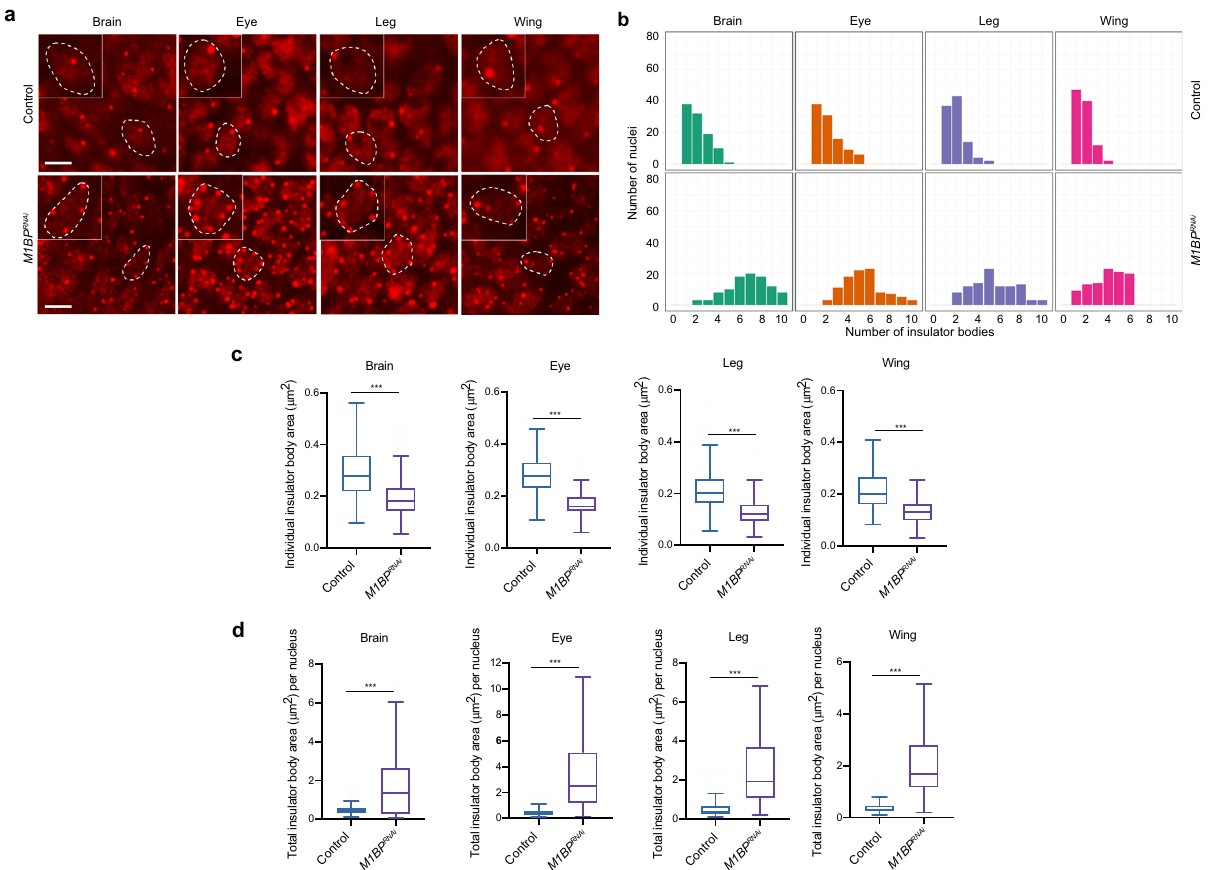
Fig. 7 Knockdown of M1BP alters nuclear organization of insulator bodies. a Epi fl uorescence imaging of insulator body localization using anti-CP190 in whole-mount brain, eye, leg, or wing imaginal disc tissues. M1BP knockdown is driven by Act5C-Gal4 driver. Insets show zoom of single nucleus outlined with dashed line in larger panel. Scale bars: 5 μ m. Immunostaining experiments were performed three times with similar results. b Histograms showing the number of insulator bodies per nucleus in the experiment exempli fi ed in ( a ). In all tissues, the number of insulator bodies is statistically signi fi cantly increased in M1BP knockdown (Kruskal – Wallis test; all Benjamini – Hochberg corrected P < 5 × 10 – 17 , n = 100). c Area measurements of individual insulator bodies in brain, eye, leg, and wing imaginal disc tissues of control and M1BP knockdown larvae are shown. Bodies were measured (Tukey plots with outliers omitted, Mann – Whitney test P < 0.001, n = 200). d Area measurements of total insulator bodies per nucleus are shown (Tukey plots with outliers omitted, Mann – Whitney test P < 0.001); Brain: (Control n = 108, M1BP RNAi n = 109), Eye: (Control n = 121, M1BP RNAi n = 168), Leg: (Control n = 107, M1BP RNAi n = 103), Wing: (Control n = 109, M1BP RNAi n = 109). Note that not all cells have discernible nuclear demarcations. c , d Data are presented as boxplots where box represents the 25 – 75th percentiles and middle line is the median. The upper whisker extends from the hinge to the largest value no further than 1.5 × IQR from the hinge (where IQR is the interquartile range), and the lower whisker extends from the hinge to the smallest value at most 1.5 × IQR of the hinge, while data beyond the end of the whiskers are outlying points that are omitted from the